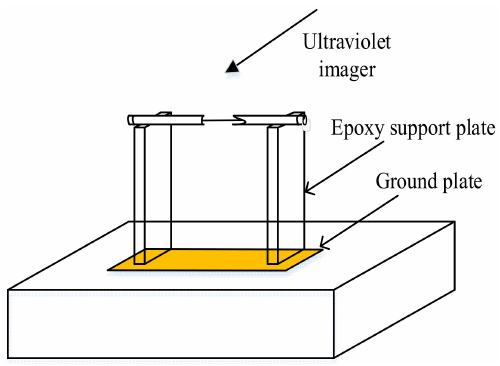
Figure 16. Corona test schematic of fuse.